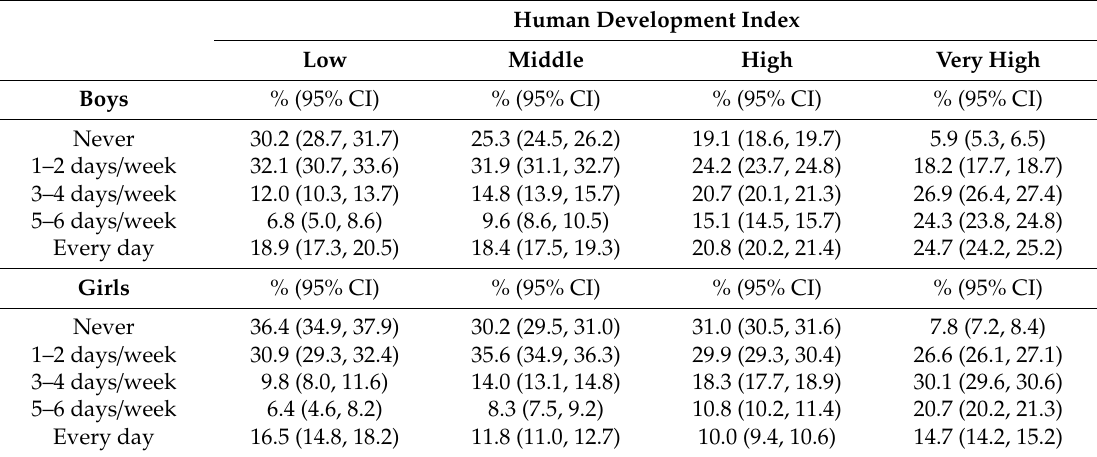
Table 3. Physical activity levels according to the human development index, stratified by